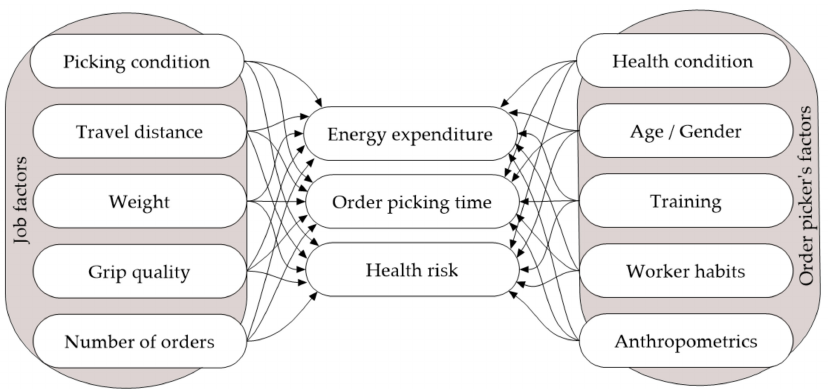
Figure 1. Factors influencing order picking time, energy expenditure and health